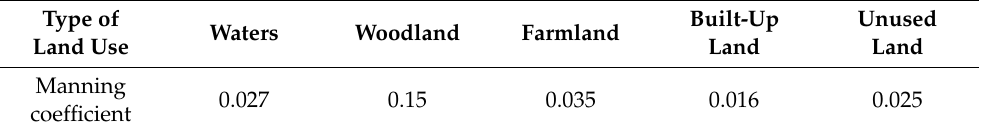
Table 2. Manning coefficients for different land use types.